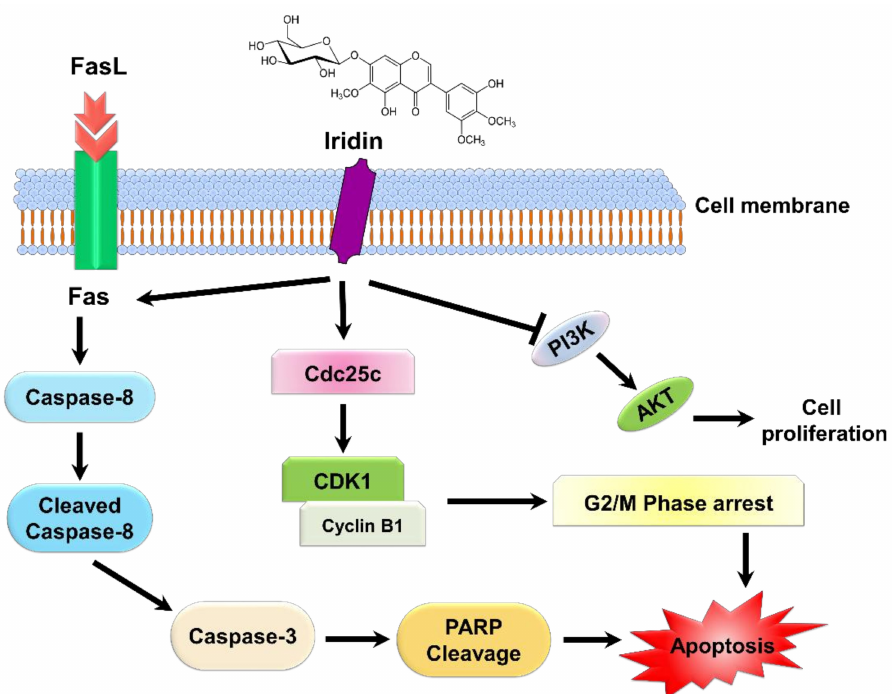
Scheme 1. Schematic diagram representing the anticancer mechanism of iridin on AGS cells through induction of G2/M phase cell cycle arrest, apoptosis by inhibition of PI3K/AKT